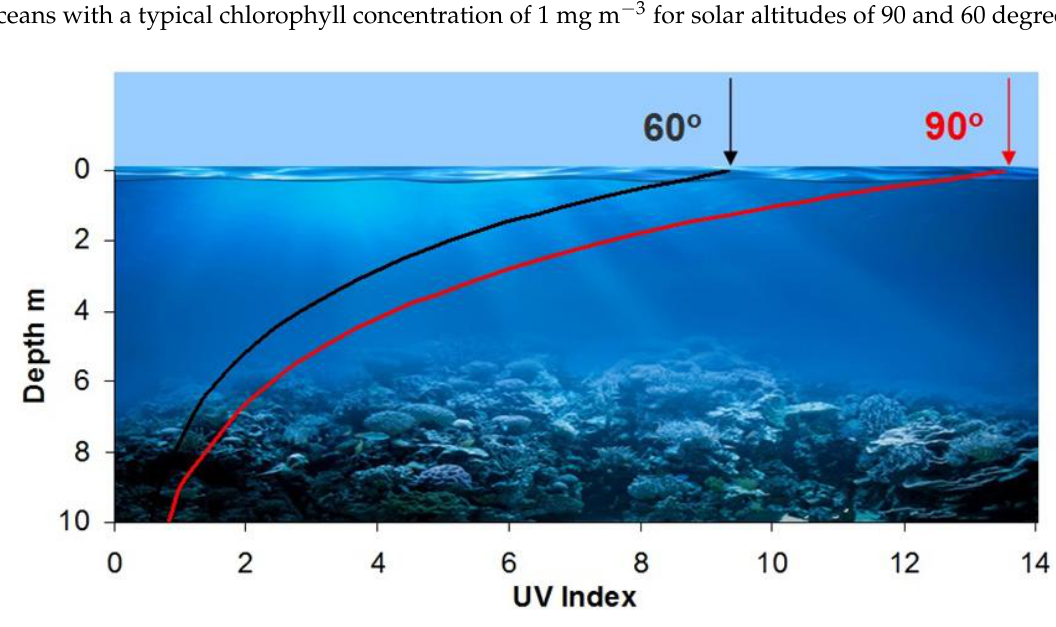
Figure 13. UV indices on a horizontal surface, e.g., the back of a swimmer, at different depths in a typical ocean for solar altitudes of 90° (red curve) and 60° (black curve) corresponding to above-surface UV indices of 13.6 and 9.5, respectively, under clear sky conditions (modified from reference [23]).